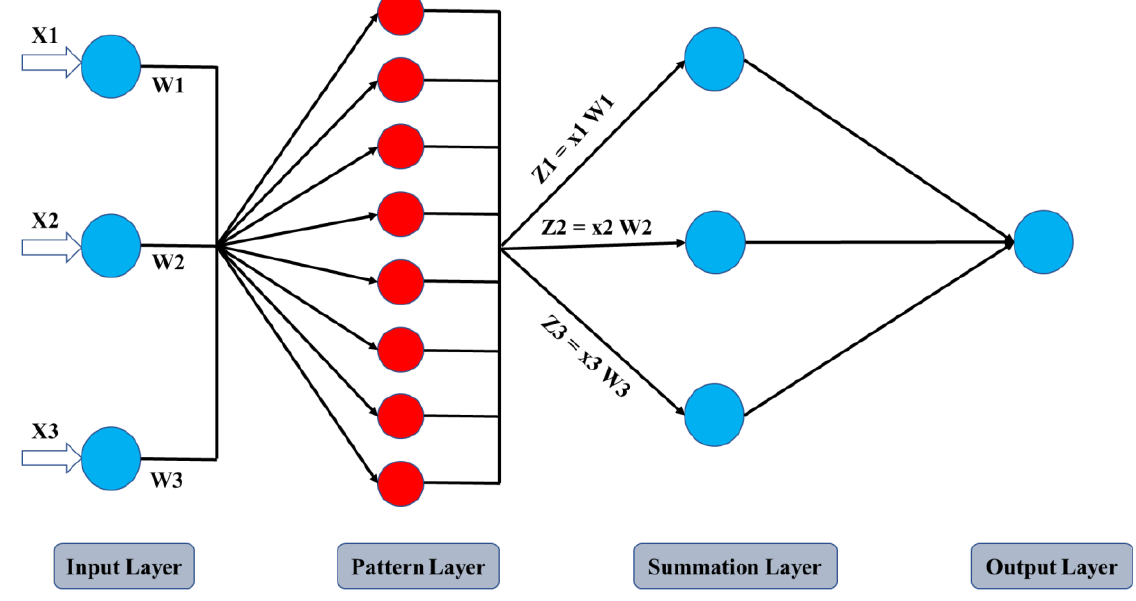
Figure 2. Probabilistic Neural Network Architecture.